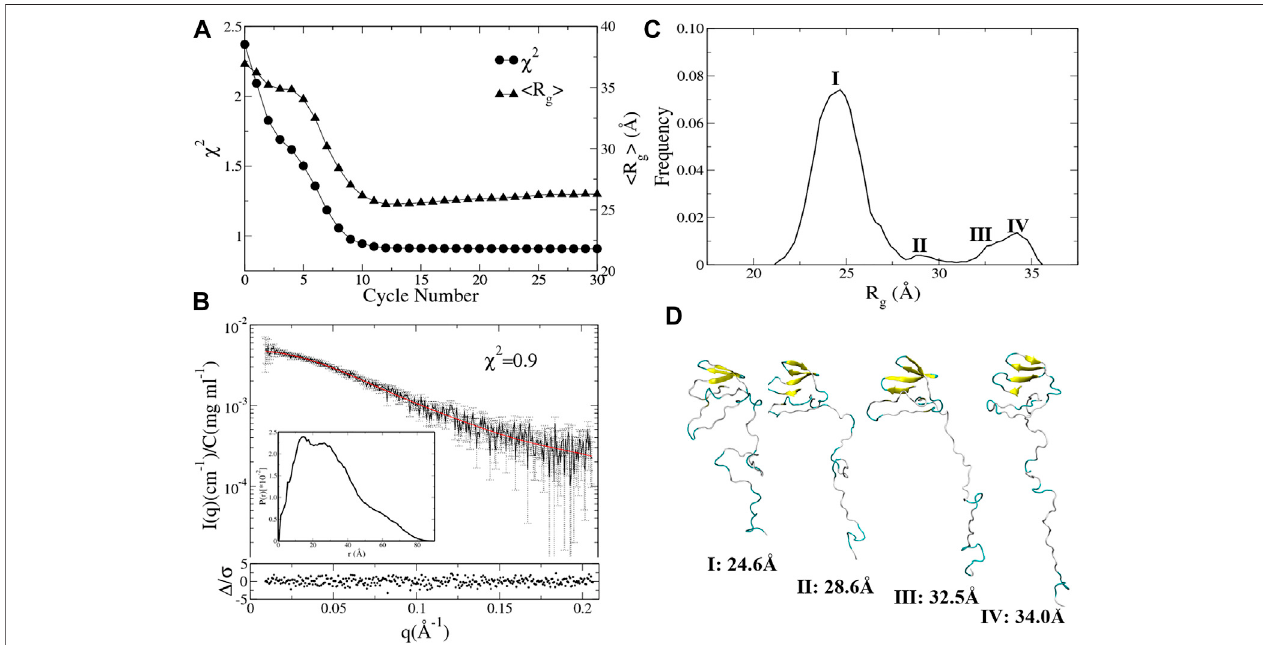
FIGURE5| Integrativemodelingfromanextended structure ofUL11( Figure1 ). (A) Theminimal χ 2 (circle)and thecorresponding < R g > (up-triangle)ateach cycle. (B) Theback-calculatedSAXSpro fi leoftheselectedensemble(redline)is fi ttedtotheexperimentaldata(blacklinewitherrors).Thelowerplotshowstheerror-weighted residual of the model fi tting. The inset is the normalized ensemble-averaged PDDF. (C) The distribution of R g values calculated from the ensembles after the 11th cycle. (D) Representative structures according to the R g